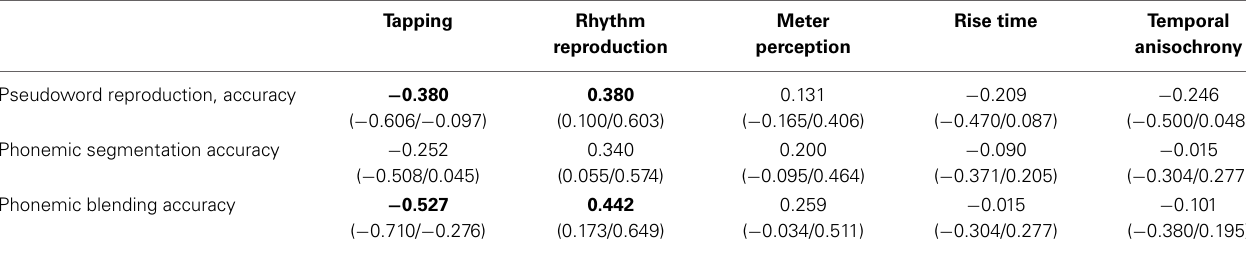
Table 2 | Spearman correlations between temporal processing tasks and phonology